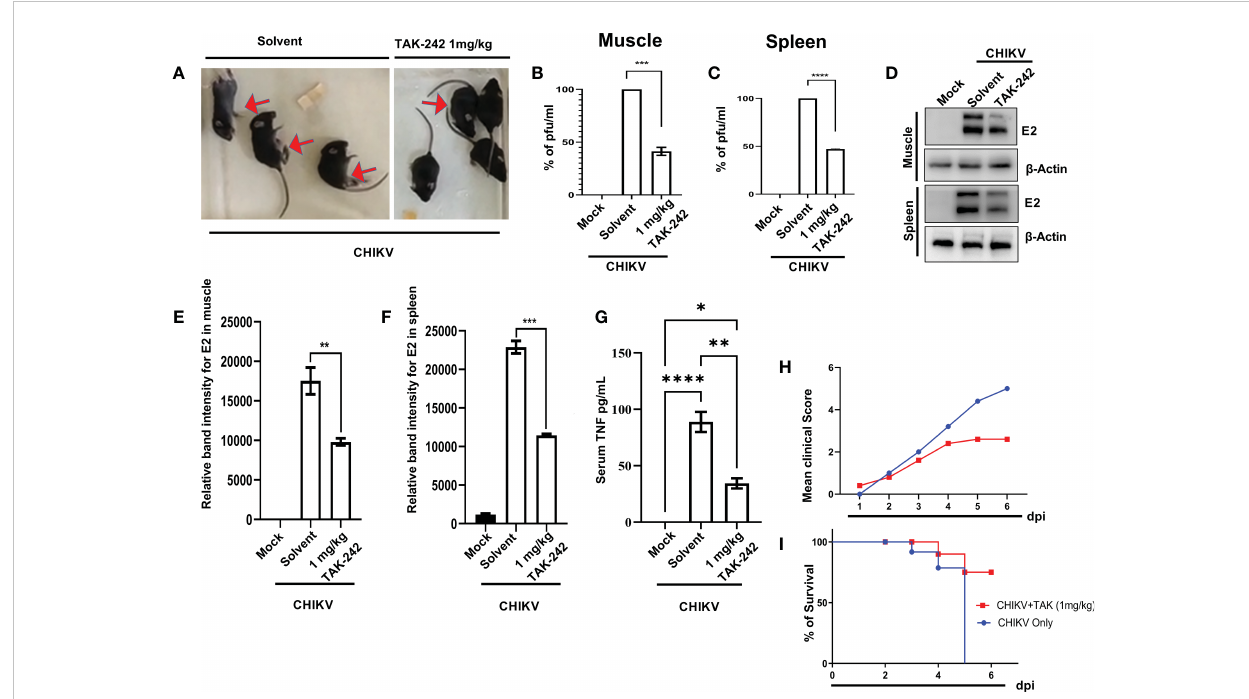
FIGURE 7 TAK-242 protects mice from CHIKV-driven pro-in fl ammatory responses and increases survival. 10-12 days old C57BL/6 mice (n=5/group) were injected subcutaneously with 10 6 CHIKV-IS and treated with TAK242 (dose:1mg/Kg bodyweight of mice) at every 24h intervals up to 4 dpi. After the mice were sacri fi ced at 5dpi, serum and different tissues were collected for further downstream experiments. To quantitate viral titre, plaque assay was performed using homogenous and fi ltered tissues sample. For this, an equal amount of quadriceps muscle and spleen were homogenized and fi ltrated using 0.22µM membrane fi lter (A) The image showing CHIKV-infected mice in the presence and absence of TAK-242 treatment. The arrows indicate mice with impaired limb movement. (B, C) The bar diagram shows % of pfu/mL in infected and TAK-242 treated mice muscle and spleen respectively. (D) Western blot showing the CHIKV E2 protein in muscle and spleen. Beta-actin was used as a loading control. (E, F) The bar diagram showing the relative band intensities of E2 in muscle and spleen respectively in mock, CHIKV and CHIIKV with TAK-242 treated groups (G) The bar diagram depicting serum TNF level in mock, infected and TAK-242 treated mice serum (H) The line diagram showing the disease symptoms of CHIKV infection which were monitored from 1dpi to 6dpi. (I) The survival curve showing the ef fi cacy of TAK-242 against CHIKV-infected C57BL/6 mice (n=6/group). All bar diagrams were obtained through the GraphPad Prism software. Data represent the Mean ± SEM of three independent experiments. p < 0.05 was considered as a statistically signi fi cant difference between the groups (ns: non-signi fi cant, * p <0.05; ** p ≤ 0.01; *** p ≤ 0.001; **** p ≤